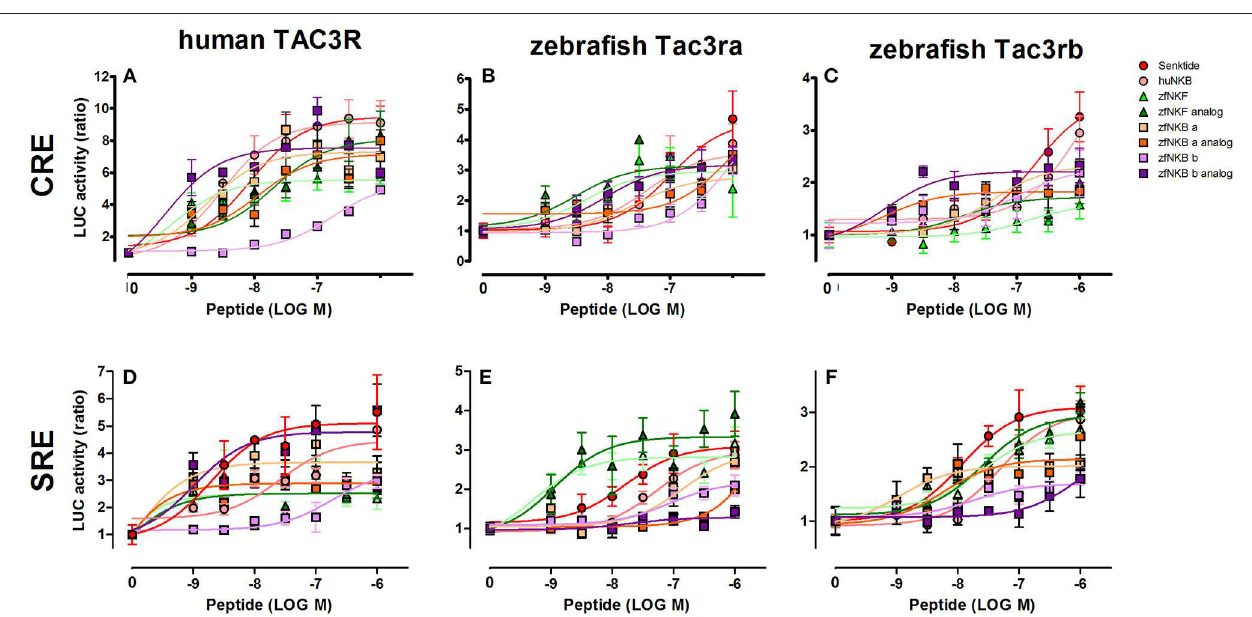
FIGURE 3 | Zebrafish NKB peptides and analogs induced transcriptional activity in CRE- and SRE-Luciferase reporters. COS-7 cells were co-transfected with human TAC3R (A,D) , zebrafish Tac3ra (B,E) , and zebrafish Tac3rb (C,F) together with a reporter plasmid. Cells were treated with various concentrations of human and zebrafish NKB peptides and their analogs. The data are expressed as the change in luciferase activity over basal and are from a single experiment representative of a total of 3 such experiments. Each point was determined in triplicate and is shown as a mean ± SEM.